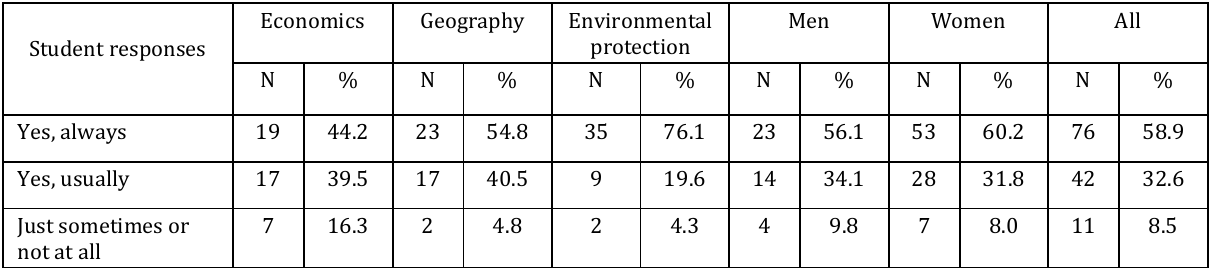
Table 6. The responses of the students to the question 16 - "Do you follow the labels on waste containers during their ejection disposal?" Student responses